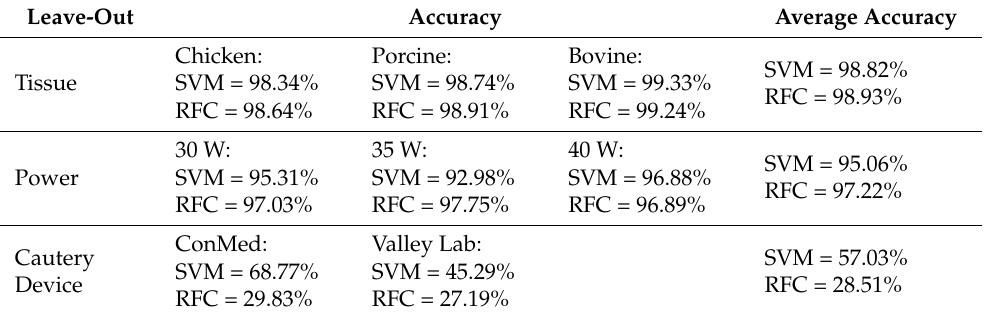
Table 3. Average accuracy from cross-validation detecting cautery state using maximal intensity and corresponding frequency.